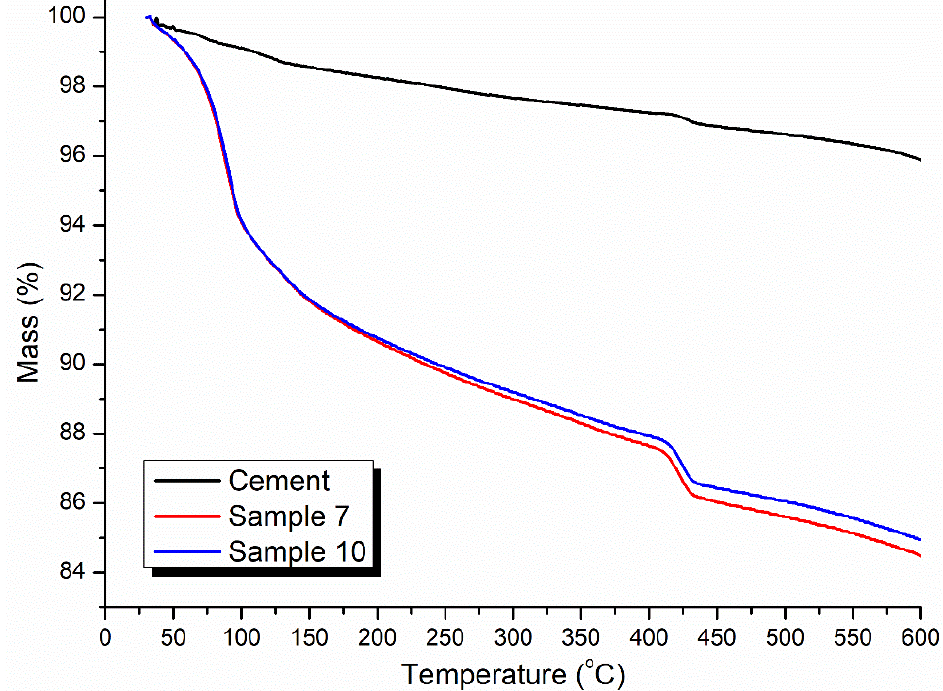
Figure 8. The TGA curves of the cement and mortar samples.